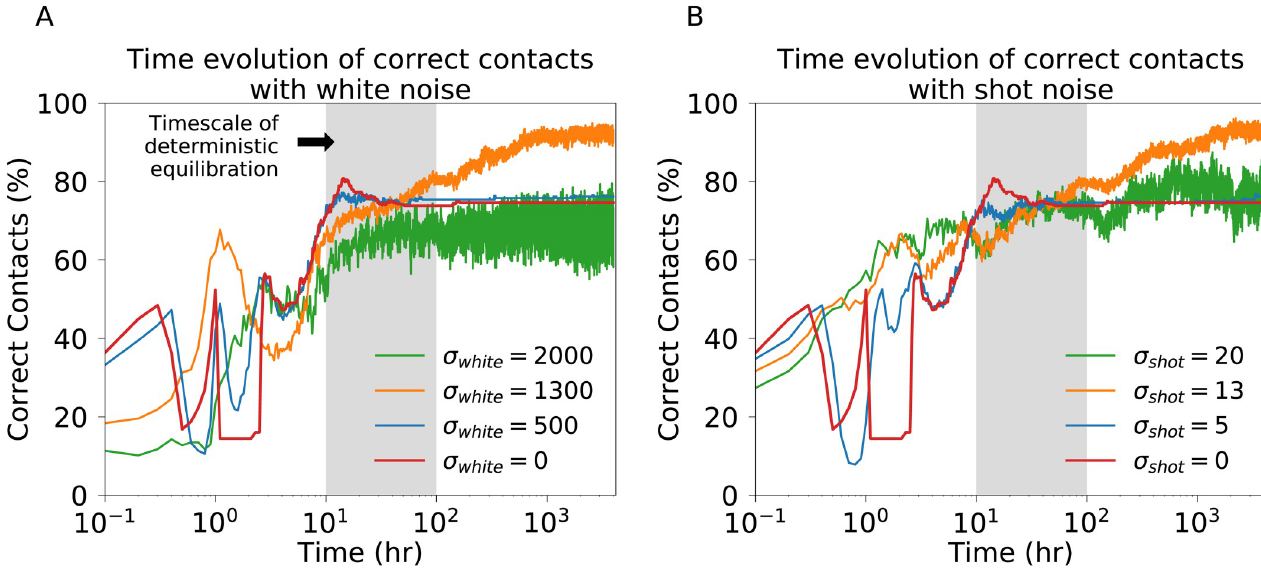
Fig 3. Time evolution of pattern formation in the multicellular system. (a) The percent of correct contacts over time for individual simulations with white noise amplitudes ( σ white = 0, 500, 1300, and 2000). The gray region shows the typical timescale of Notch equilibration and cell cycle. The systems start from randomized initial conditions and relax towards more ordered patterns within the first 10 − 10 2 hr (i.e., Notch equilibration). Afterwards, the stochastic fluctuations dominate, leading to a separation in the order of systems based on noise amplitude. (b) Same as (a) but for corresponding shot noise levels ( σ shot = 0, 5, 13, and 20).